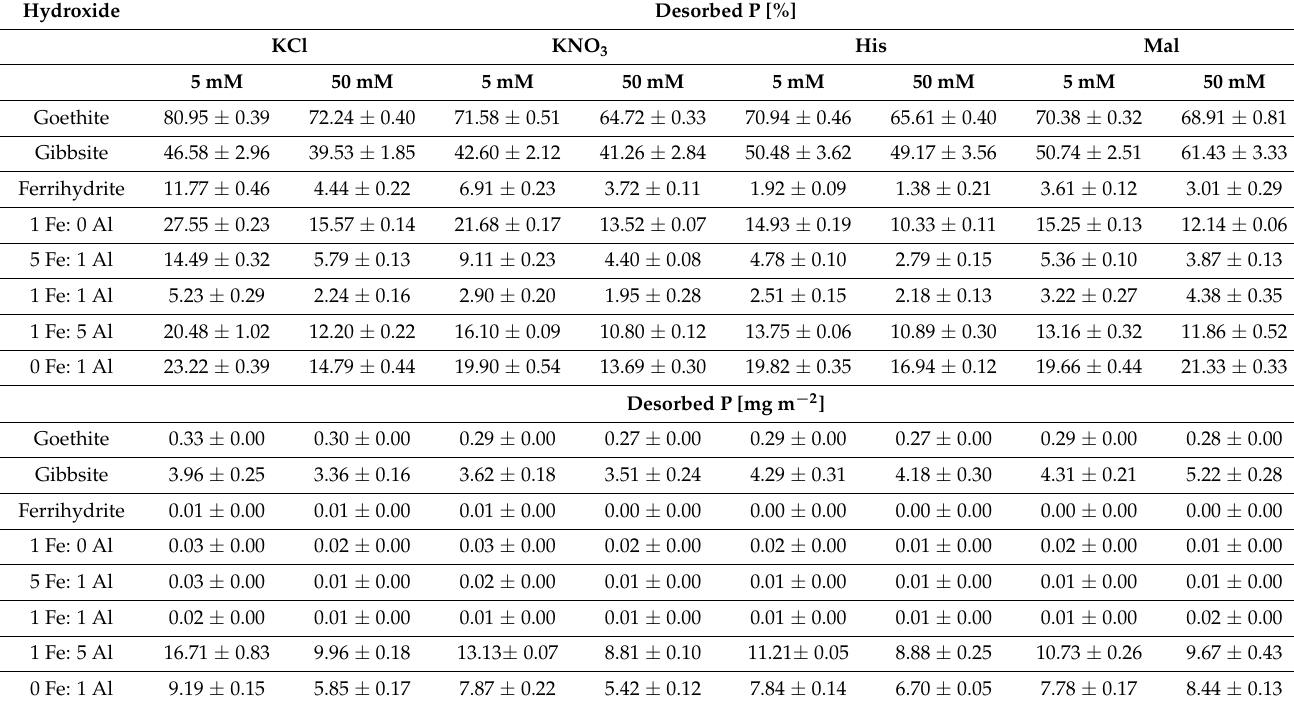
Table 3. Total P desorption after 336 h by using desorption solutions KCl, KNO 3 , histidine (His), and malic acid